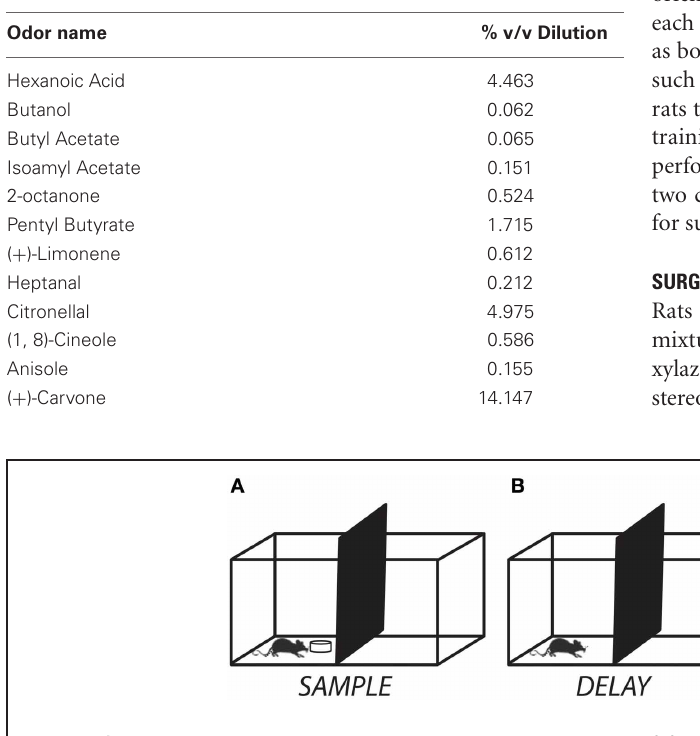
FIGURE 1 | Experimental setup for the delayed match-to-sample task. (A) At the start of a trial, the rat was presented with a ceramic dish containing odorizedbedding. (B) Afterallowingfor10–15 sofinvestigation,thesampleodor dish wasremoved and adelay period (ranging from 0sto 10min)wasimposed.